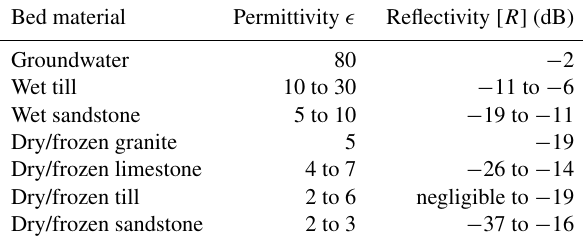
Table 1. Dielectric and reflective properties of subglacial materials based on a compilation of past values by Bogorodsky et al. (1983), Martinez et al. (2001) and Peters et al. (2005). The bulk values take into account typical ranges of saturation and porosity for the di- electric mixing of water and ice with the background material. The relative dielectric permittivity of ice is 3.15, which means that dry (just the background dielectric) or frozen material (a mixture of the background dielectric with ice) produces a similar range for [ R ]